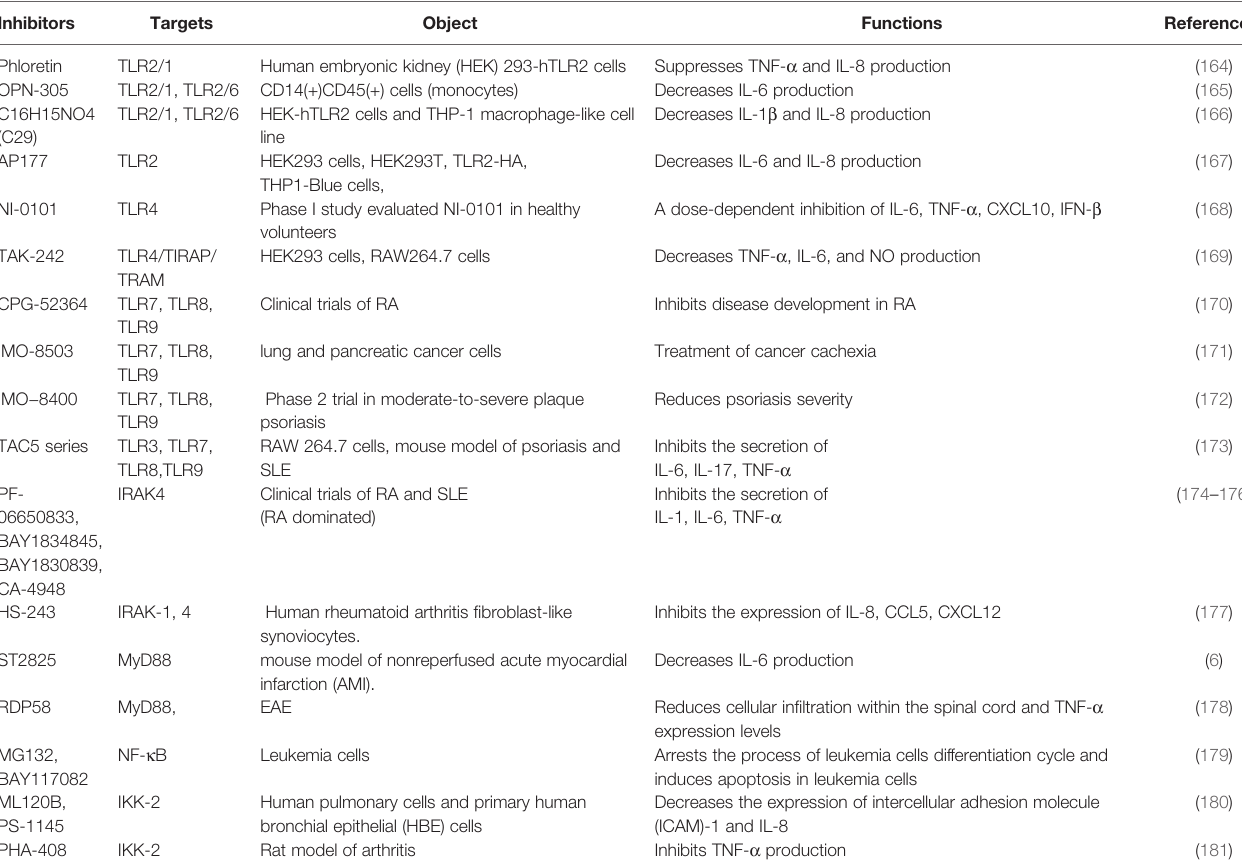
TABLE 1 | Inhibitors of TLRs signaling pathway. Inhibitors Targets